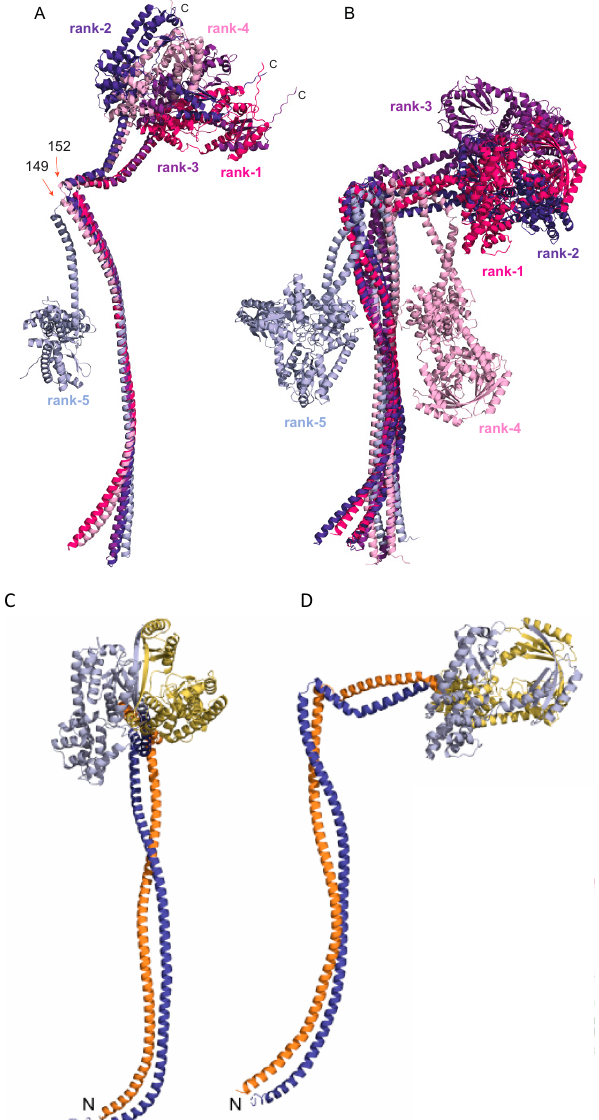
Figure 6. AlphaFold models of the full-length B. subtilis RNase Y. ( A ) The five best 3D models of the monomer. ( B ) The five best 3D models of the dimer. The models are numbered from 1 (the best) to 5 (the worst). The residues at the edges of the turn are highlighted as orange arrows. ( C , D ): Two different views showing the relative orientation of the two chains in the dimer of the best AlphaFold model for the full-length B. subtilis RNase Y. One chain is colored orange and yellow and the other is colored dark blue and light blue, for the N- and C-terminal domains, respectively.